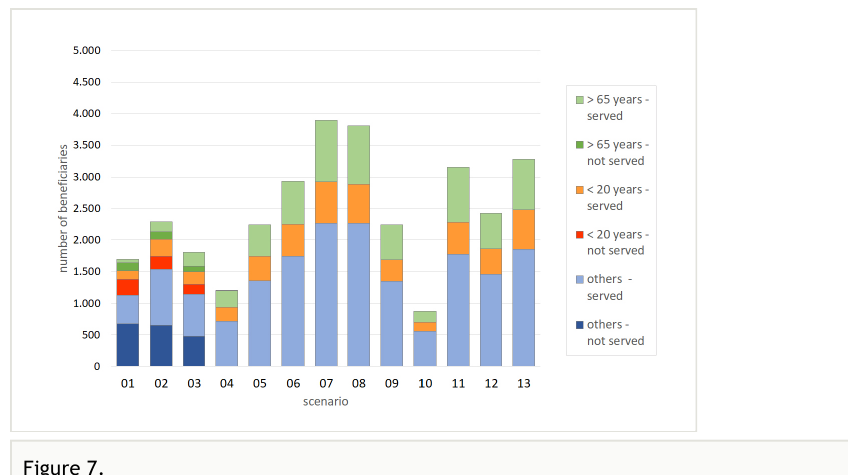
Expected bene fi ts produced by the di ff erent scenarios in terms of enhanced opportunities for nature-based recreation: number of bene fi ciaries broken down into di ff erent vulnerability